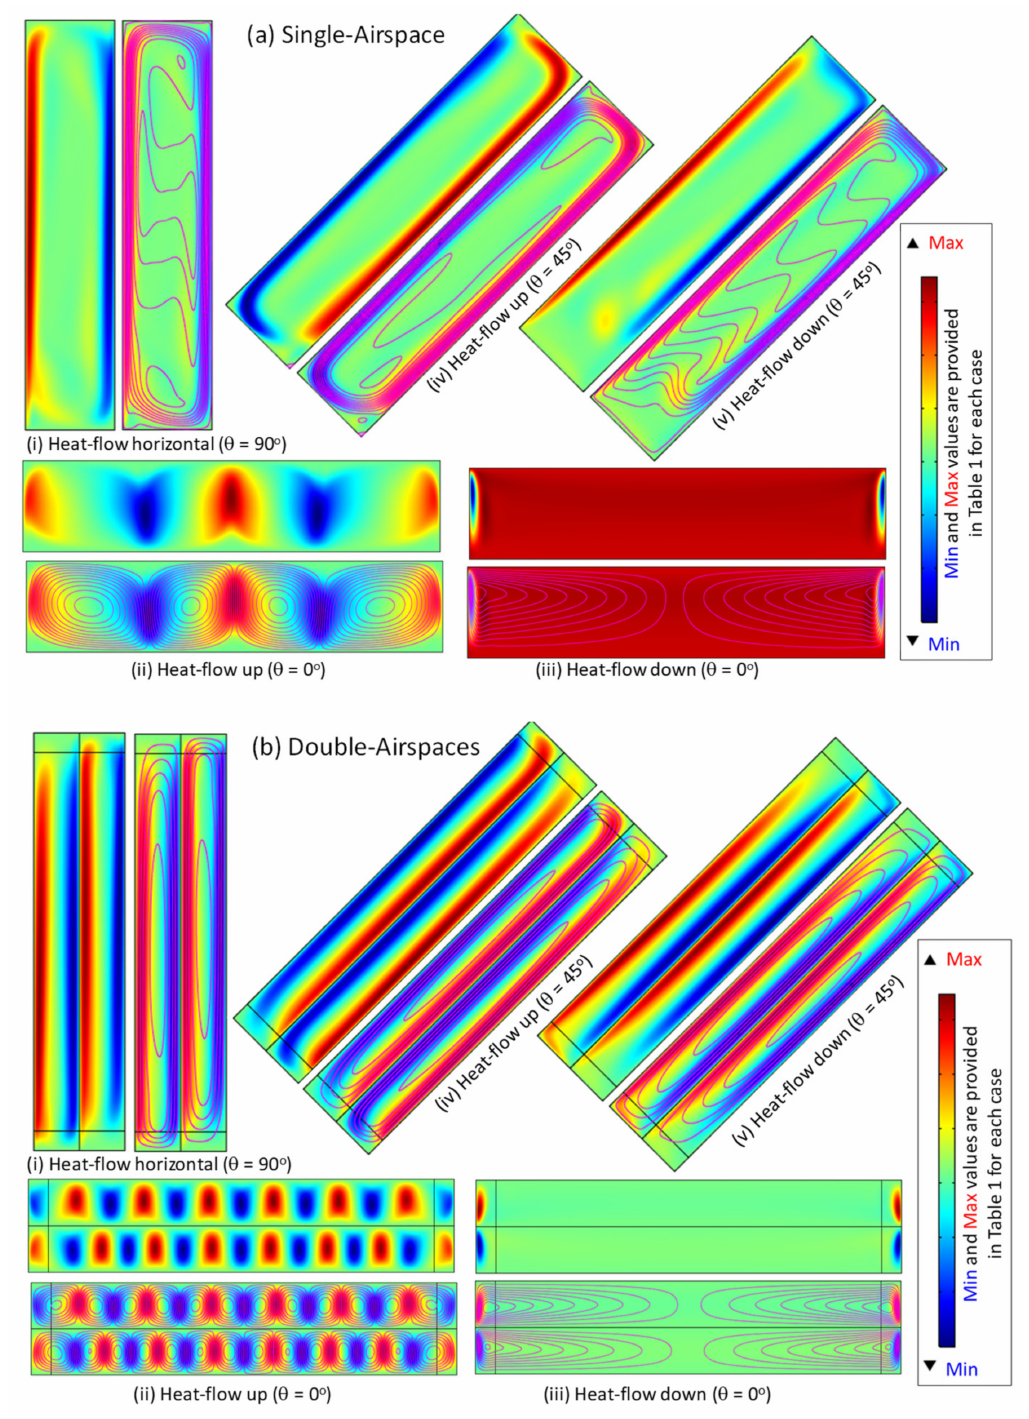
Figure 6. Distributions of vertical velocity and velocity field streamlines in ( a ) a single airspace and ( b ) double airspaces (H = 406 mm (16 inches) and δ = 89 mm (3.5 inches), T H = 32.2 ◦ C (90 ◦ F), T L = 15.6 ◦ C (60 ◦ F), E =